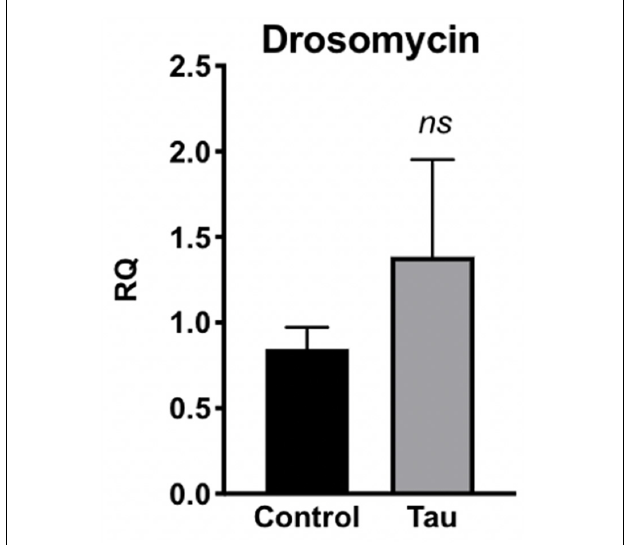
FIGURE 4 | Tau transgenic flies show no significant difference in antifungal AMP transcript levels. qPCR targeting the antifungal peptide transcript drosomycin showed no significant difference in expression levels between tau transgenic and control flies ( n = 6, p > 0.05). Data are shown as average ±